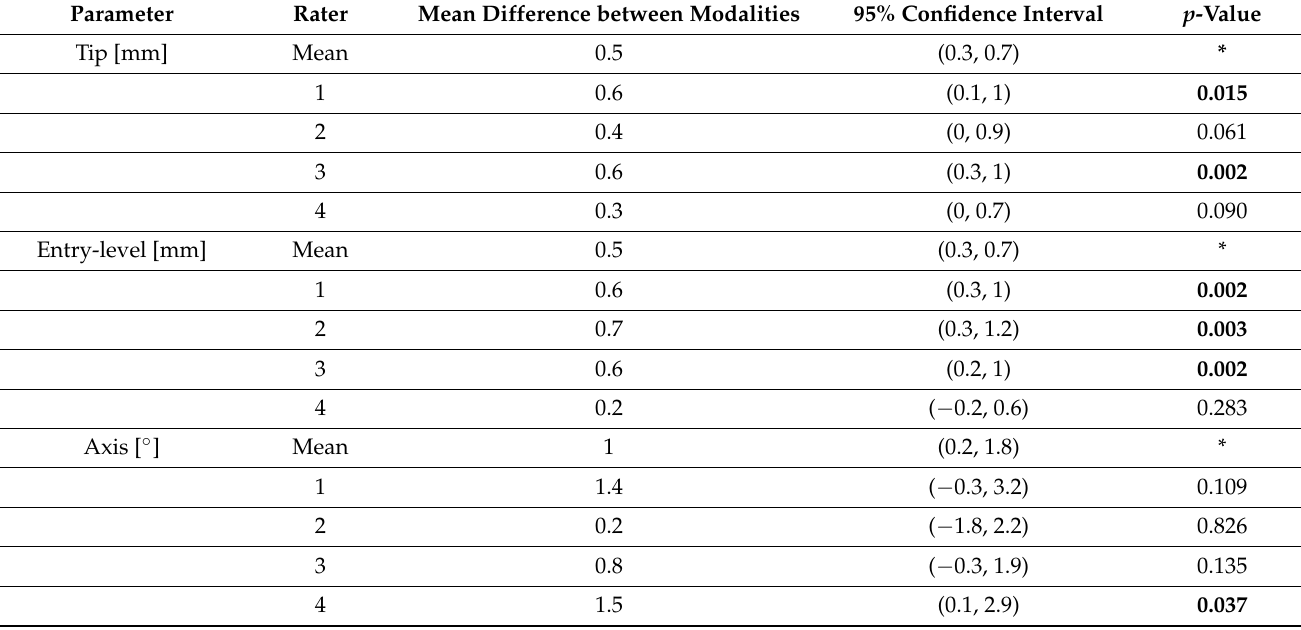
Table 1. Geometric deviations between the two imaging modalities (CBCT and MRI) were compared for each rater separately, for the implant tip, entry-level, and axis. Significant differences are marked in bold. * To avoid artificially increasing the study power, no statistical analysis of mean values was